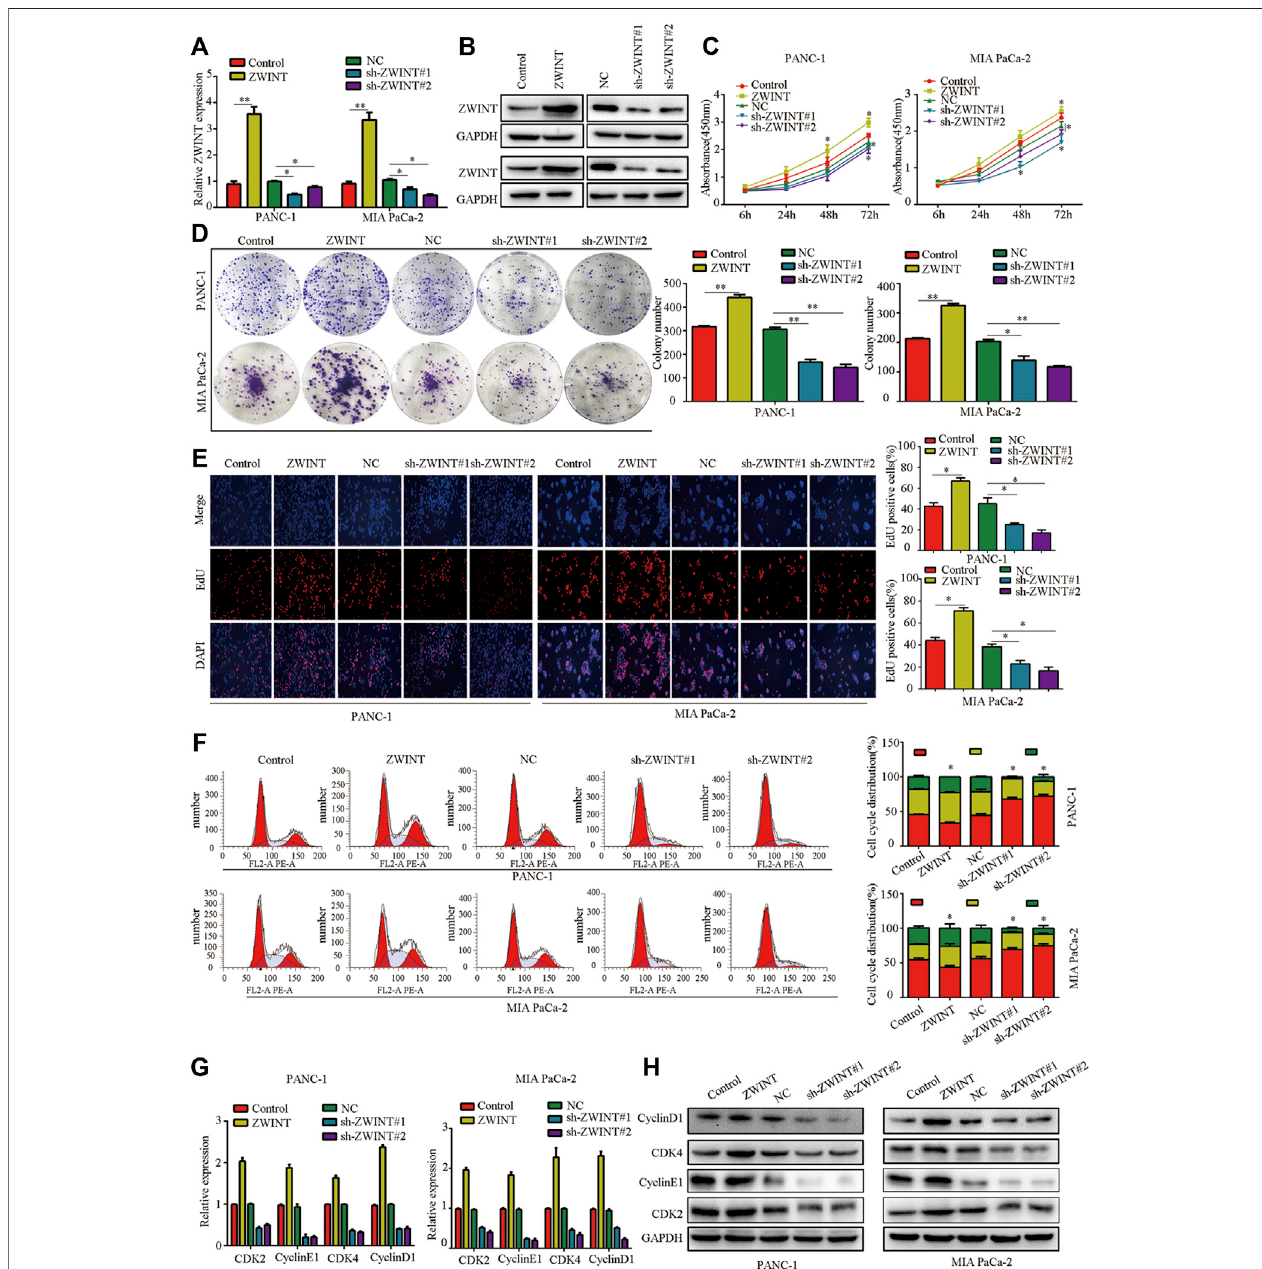
FIGURE2| ZWINTenhancesPCcellproliferationinducesG1/Sphasetransitioninvitro. (A,B) q-RT-PCRandwestern-blotscon fi rmedtheknockdownandoverexpressed of ZWINT. (C,D) CCK-8 and plated formation analysis of the growth ability of PC cell. (E) EDU assay was performed to analysis the proliferation of PC cell. (F) Cell cycle analysis showed the effects of ZWINT on PC cell cycle regulation. (G-H) . q-RT-PCR and western-blots analysis of the cell cycle associated genes expression.